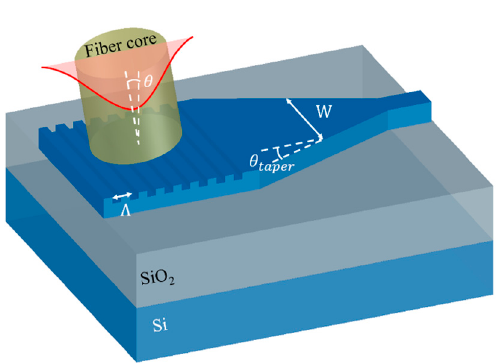
Figure 1. Schematic structure for a 1D grating coupler (GC) with linear waveguide taper and key parameters: period Λ , fiber tilt angle θ , varying taper width W and taper angle θ taper .